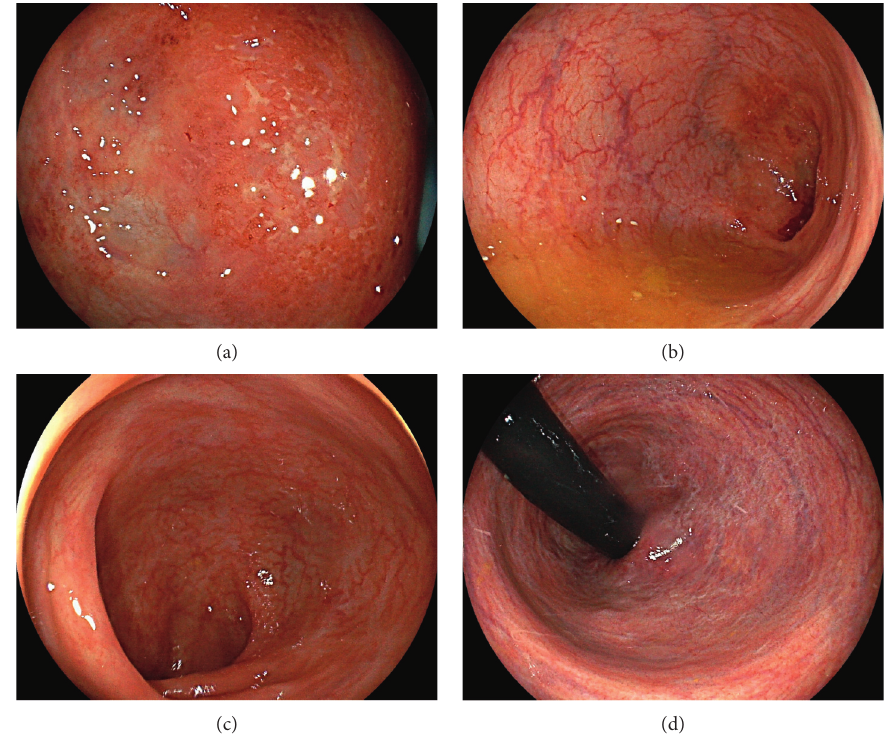
Figure 3: Colonoscopy images. Coarse reddish mucosa with yellowish-white pus-like deposits is observed in the splenic flexure (a). Atrophic mucosa with multiple ulcer scars is also seen in the descending to sigmoid colon region (b–d). These endoscopic findings are consistent with those for ulcerative